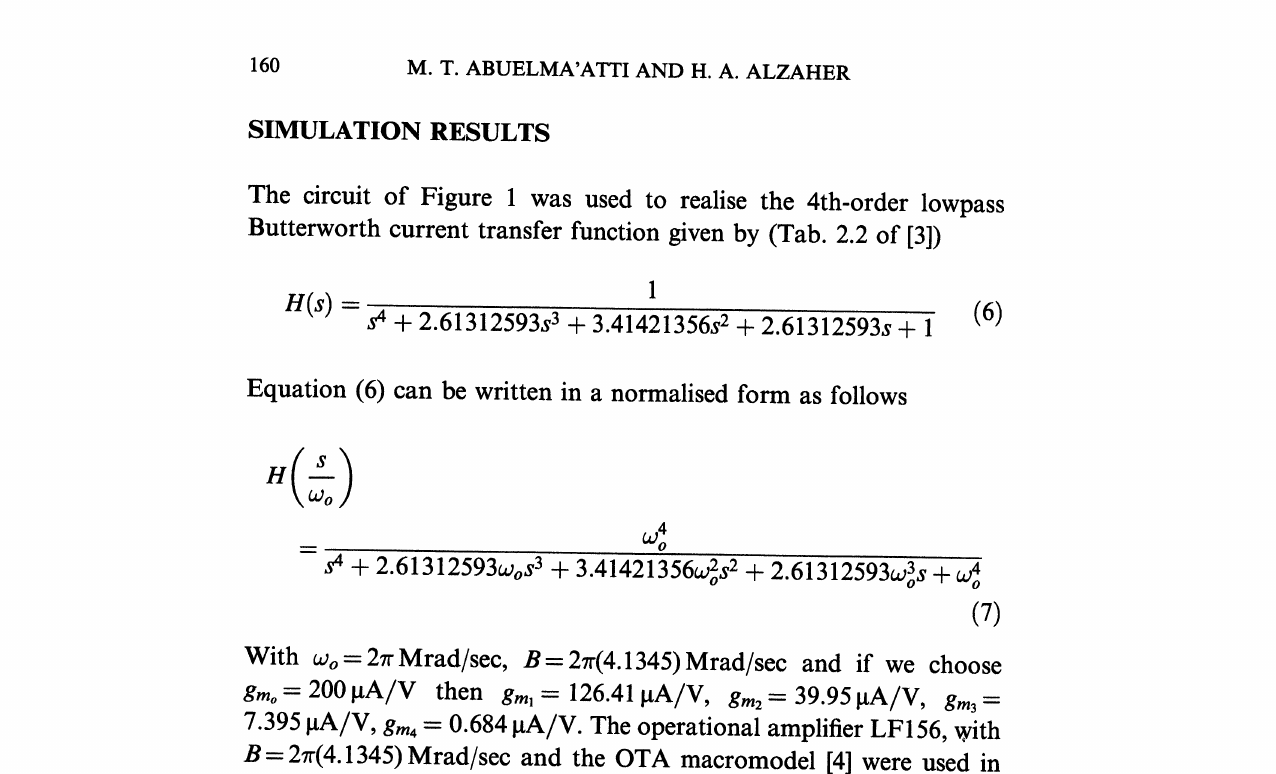
FIGURE 2 Simulated (--) and calculated x results obtained from the lowpass response of